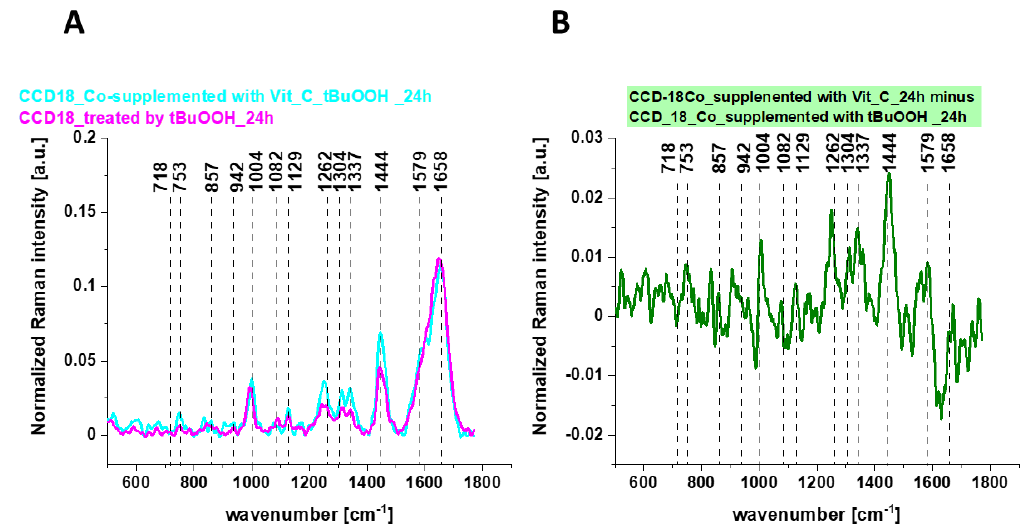
Figure 9. The average Raman spectra obtained for CCD-18 Co human normal colon cells in oxidative stress condition, the average Raman spectra typical for CCD-18 Co human normal colon cells supplemented with vitamin C and tBuOOH for 24 h ( A ) and the differential Raman spectrum ( B ) calculated based on spectra presented on panel (A); excitation laser line 532 nm, number of cells=6 for each type.